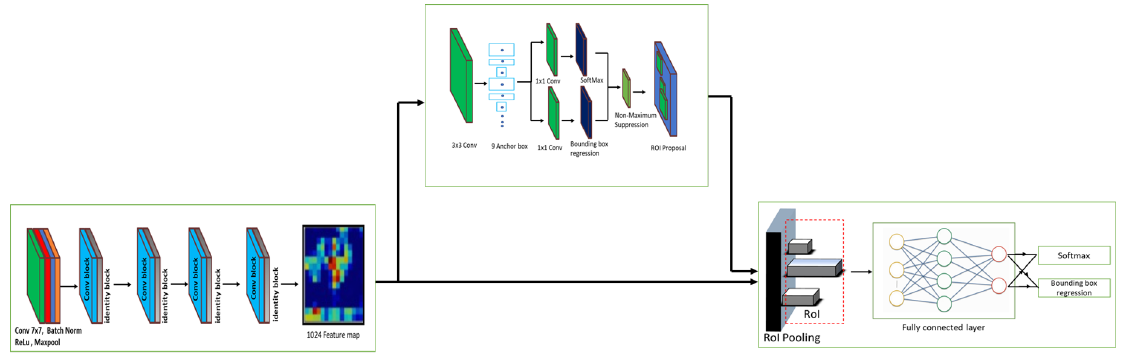
Figure 6. Faster RCNN RestNet